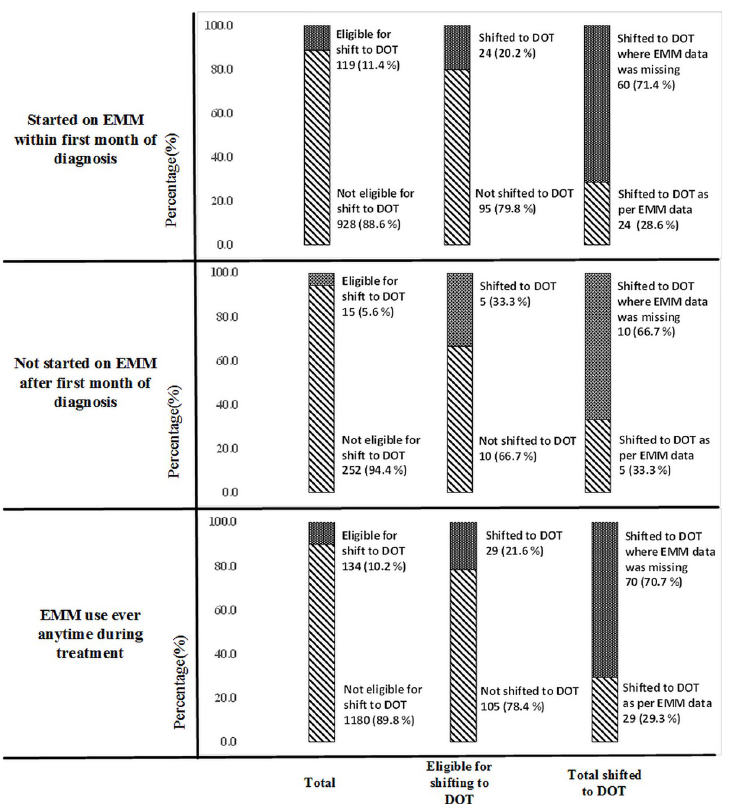
Fig 3. Shift to DOT among people with TB using EMM in the 30 selected counties of China between July and December, 2018 � . TB–tuberculosis; EMM–electronic medical monitor; DOT- directly observed treatment � Of 2294 notified people with TB, 2227 has EMM eligibility data recorded. Of 2227, 1810 were eligible to use EMM at notification. Of 1810, 1047 used EMM within first month of diagnosis. Of 763 that did not use EMM within first month, 267 used EMM later during